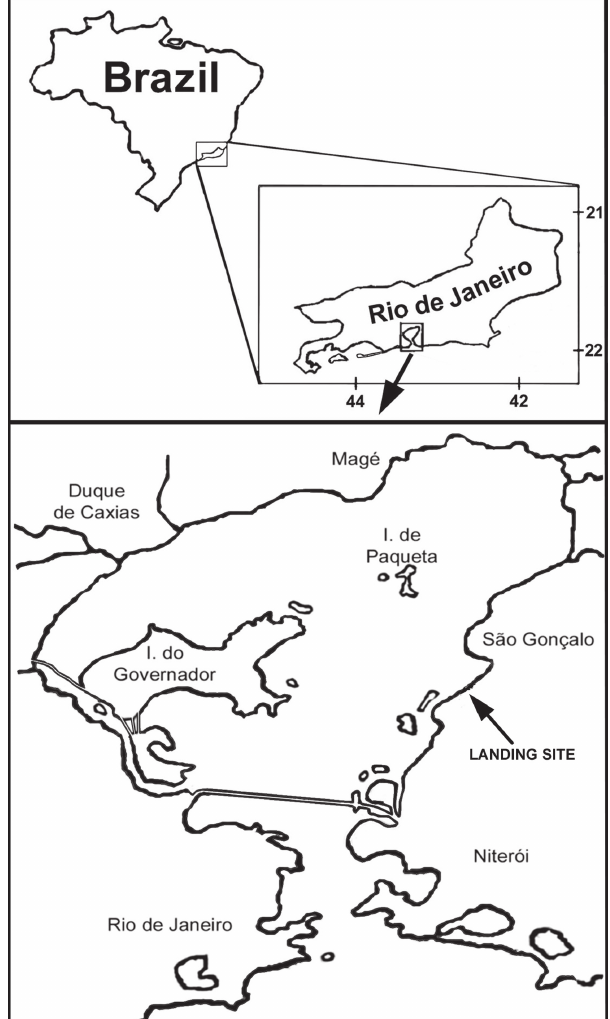
Fig. 1. Geographical location of Guanabara Bay, with the surrounding